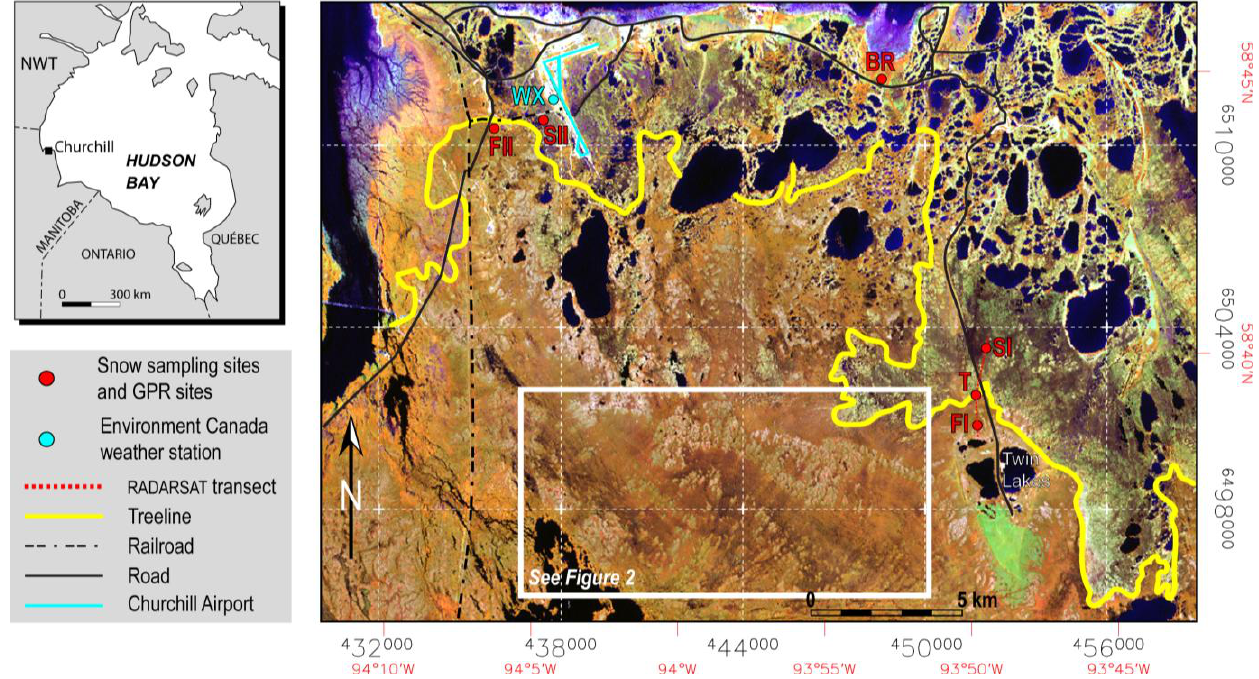
Figure 1. A Landsat ETM+ RGB (Red, Green, Blue) color composite image (4,5,3), courtesy of the US Geological Survey, showing the study area and the location of the sampling